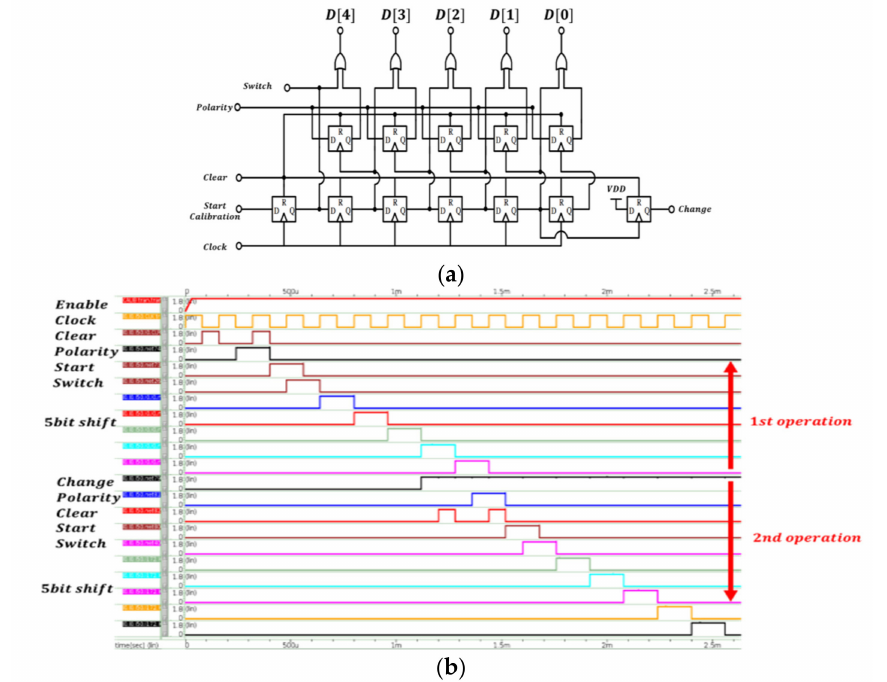
Figure 16. ( a ) Proposed SAR logic circuit; ( b ) the operational sequence of SAR logic circuit. Clear, the reset signal; Start Calibration, start to the calibration signal; Polarity, from the polarity of the comparator; Clock, the clock signal; Switch, output to control the calibration switch; Change, divide the first operation and the second